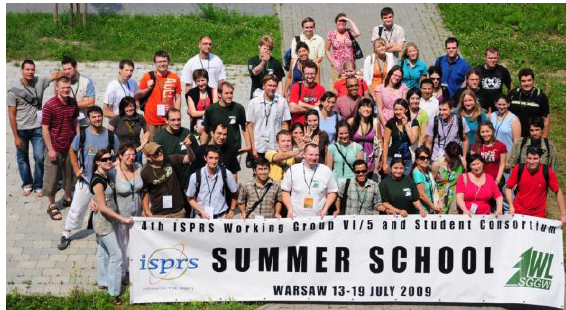
Figure 8. 4 th Summer School Participants in Warsaw,